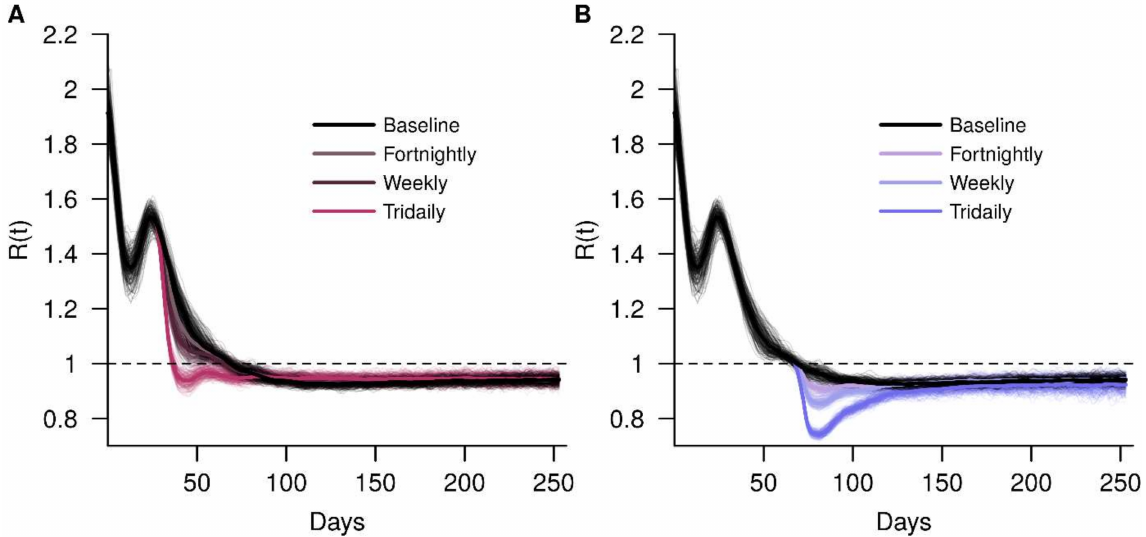
Figure 3. Effects of RRT on the COVID-19 transmission by measuring the effective reproduction num- ber R ( t ) of the baseline simulation, fortnightly, weekly and tridaily; RRT interventions implemented at ( A ) early implementation and ( B ) peak